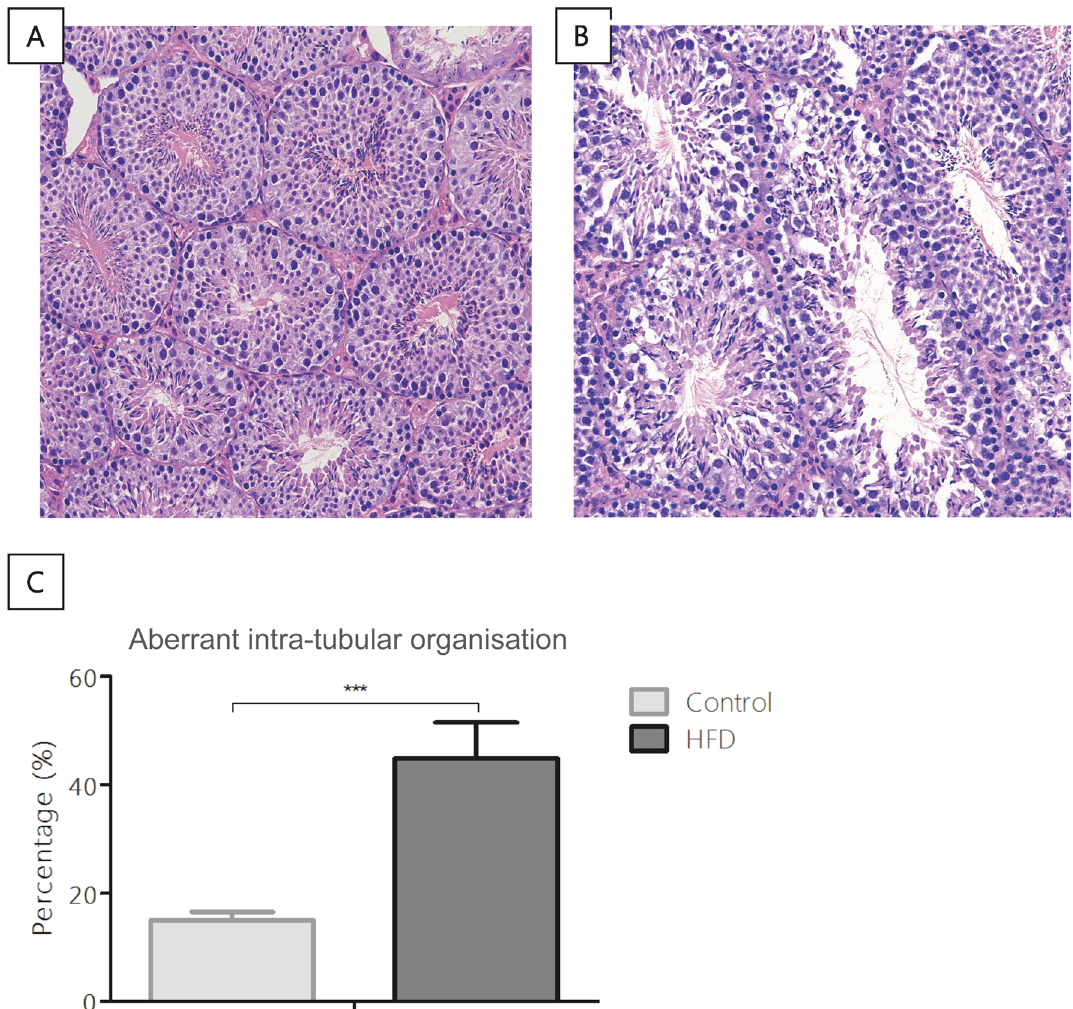
Figure 1. Analyses and representative images of testis morphology. ( A ) Normal tubules. ( B ) Tubules with an aberrant intra-tubular organisation. ( C ) Quantification of the seminiferous tubules (in total 52 tubules per mouse) with an aberrant intra-tubular organisation. Original magnification × 200. Control n = 13. HFD n = 14. ***p <